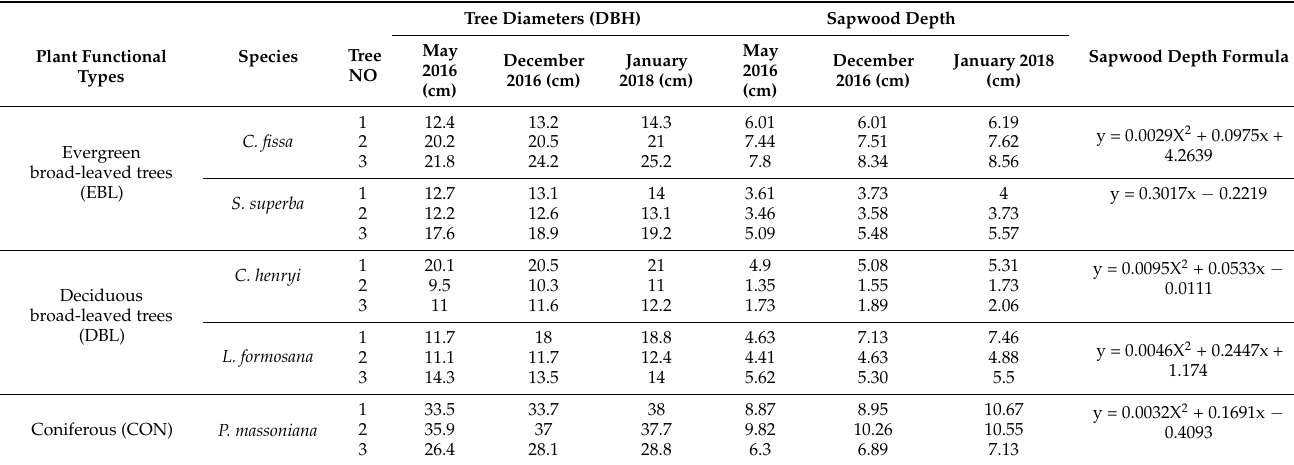
Table 1. Sample tree diameters at breast height (1.3 m above soil surface) and their sapwood depths at different dates during the study period. Trees are grouped according to functional types, including evergreen broad-leaved trees, EBL; deciduous broad-leaved trees, DBL; coniferous,